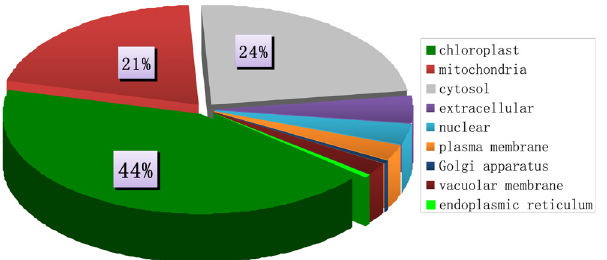
Fig 3. Subcellular location of lysine succinylome of